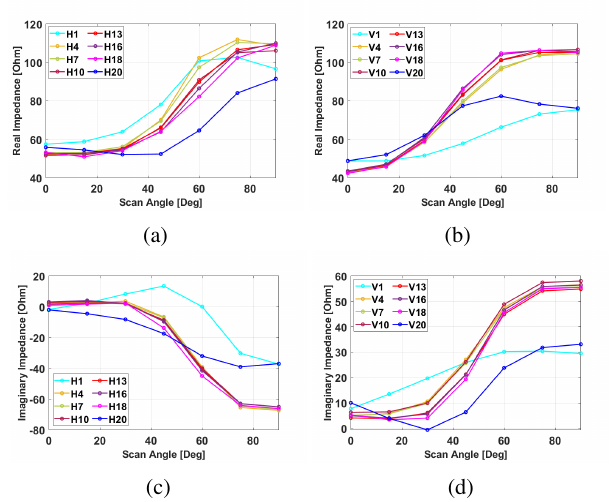
FIGURE 13: Active Z-Parameters for some of the (a) real (Z) H and (b) real (Z) V (a) imag (Z) H and (c) imag (Z) V of 2X20 Array at 2.8 GHz and d=0.5 λ